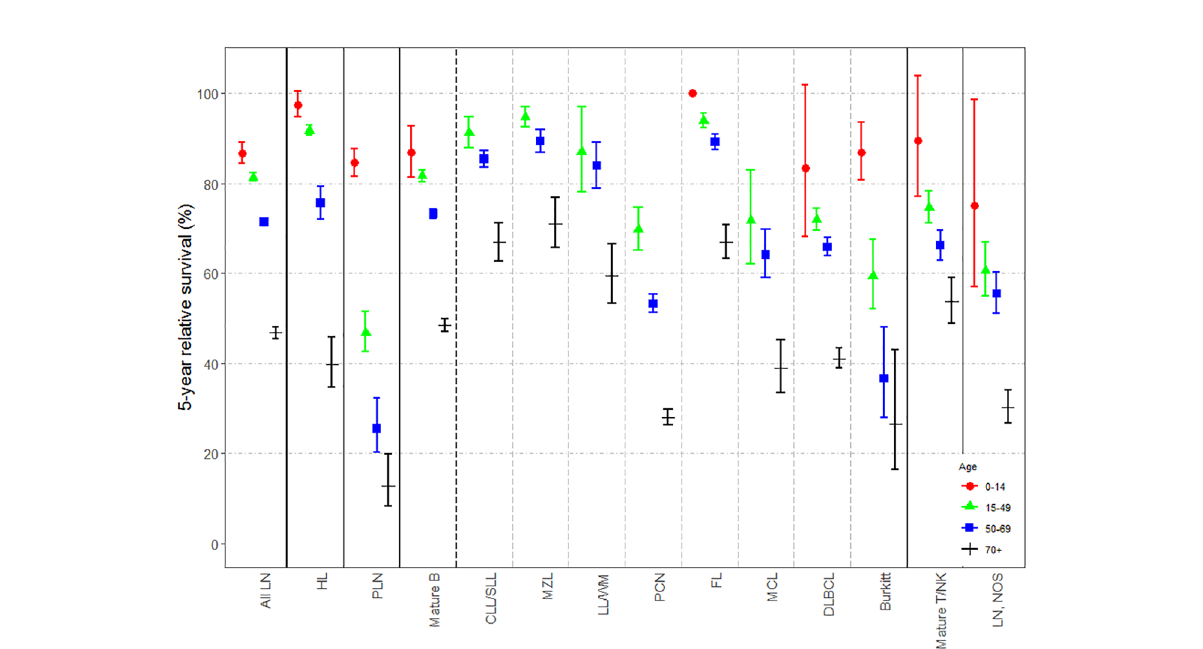
FIGURE 2 Estimates of 5-year net survival for patients with lymphoid neoplasms diagnosed in 2002-2013, in Spain, according to age-group (0-14, 15-49, 50- 69 and 70 or more). LN, Lymphoid neoplasm; HL, Hodgkin lymphoma; PLN, precursor lymphoid neoplasms; mature B, mature B-cell neoplasms; CLL/SLL, chronic lymphocytic leukemia/small lymphocytic lymphoma; MZL, marginal zone lymphoma; LL/WM, lymphoplasmacytic lymphoma/ Waldenström ’ s macroglobulinemia; PCN, plasma cell neoplasms; FL, follicular lymphoma; MCL, mantle cell lymphoma; DLBCL, diffuse large B-cell lymphoma; Burkitt, Burkitt lymphoma/leukemia; Mature T/NK, mature T-cell and NK-celll neoplasms; NOS, not otherwise speci fi